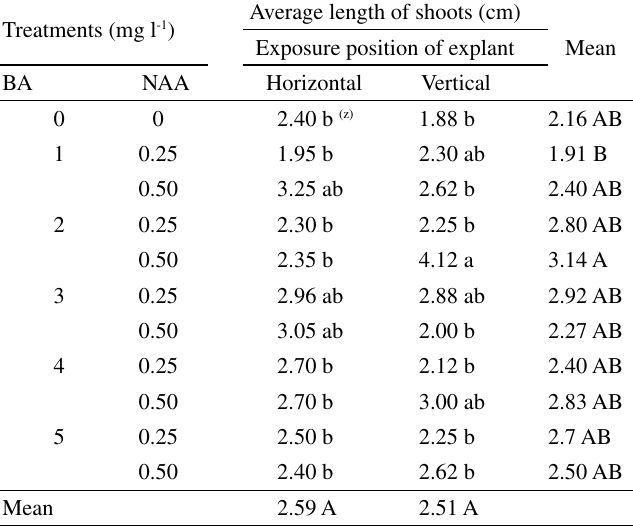
Table 3 - The interaction effect of different concentrations of BA and NAA, and exposure position of explants on the proliferation rate of ‘Green’ Treatments (mg l -1 )